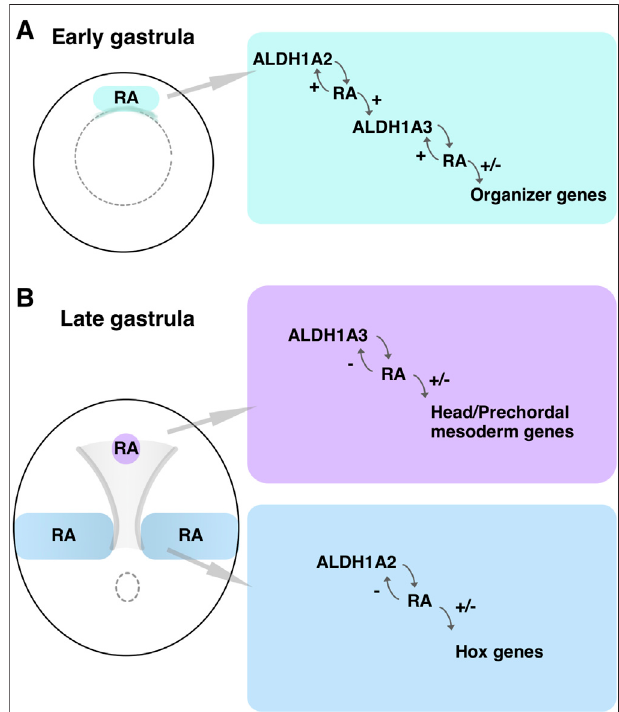
FIGURE 9 | RA biosynthetic/signaling centers during gastrulation. (A) Schematic depiction of an early gastrula embryo where the domain of overlapping aldh1a2 and aldh1a3 expression in the Spemann-Mangold organizer is marked (green box). The RA producing and regulatory activities are summarized. (B) Schematic summary of the two RA biosynthetic/signalingcentersduringlategastrula.Thedomains ofexpression andactivityof aldh1a2 inthetrunk(blue)and aldh1a3 intheLEM/PCM(purple) are